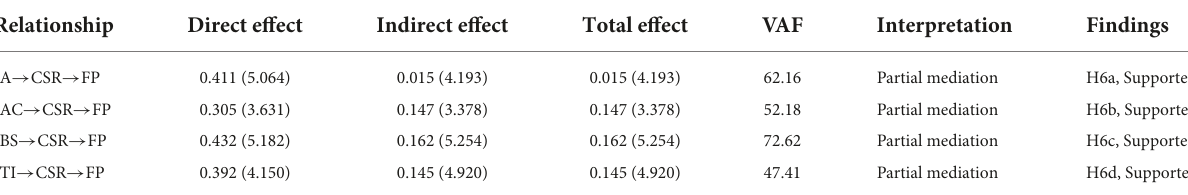
TABLE 4 Mediation